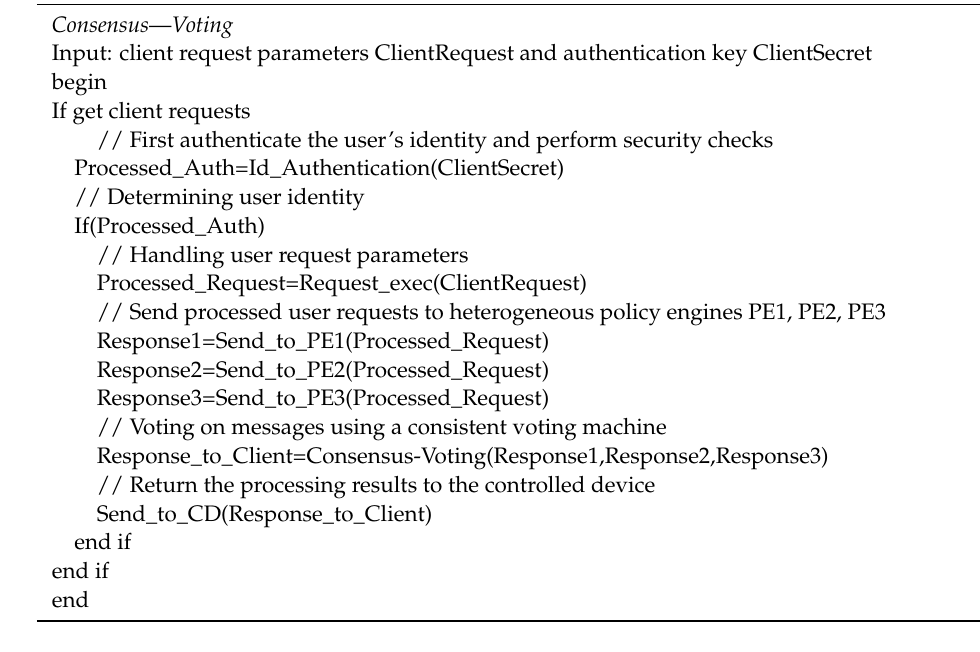
Algorithm 1. Consensus voting.